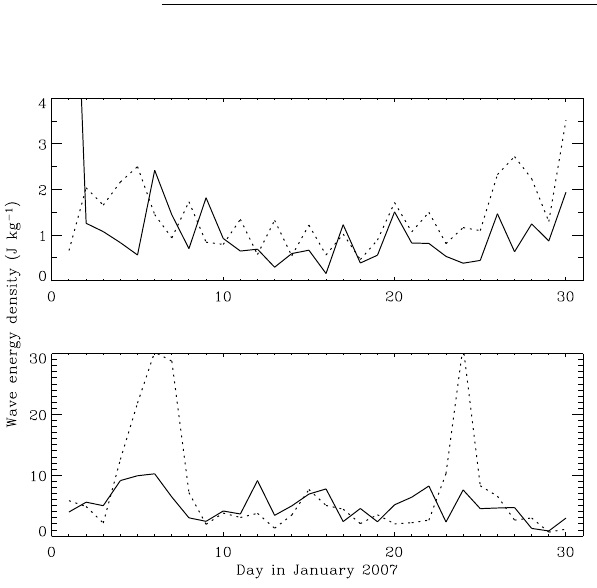
Fig. 7. Similar to Fig. 3, but for GWs in January 2007.